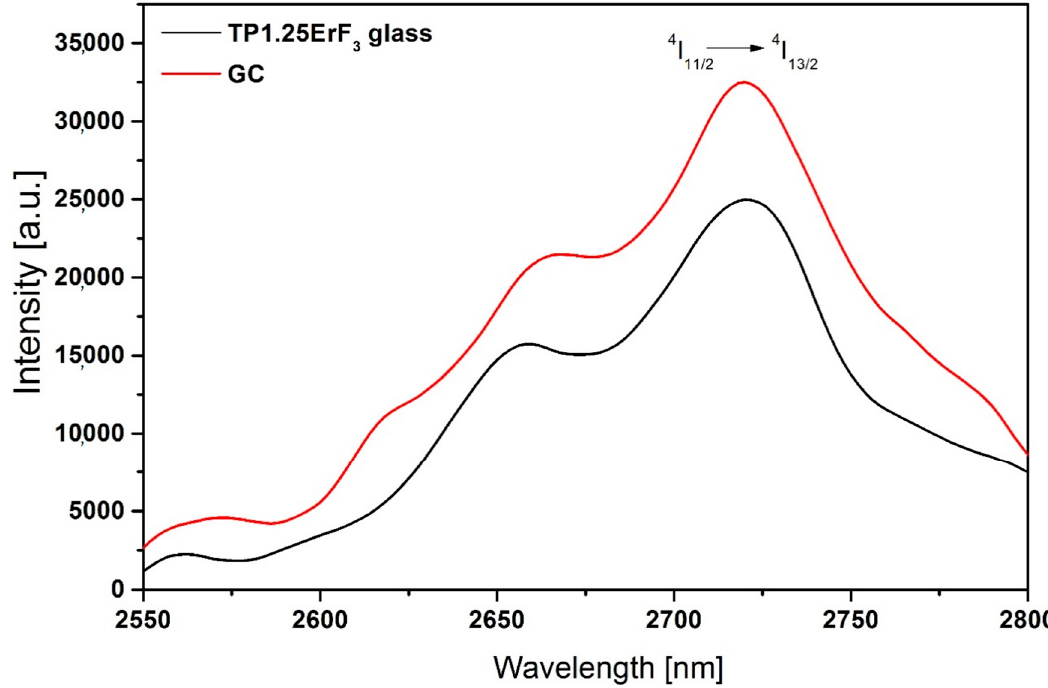
Figure 19. 2725 nm emission spectra of TP1.25ErF 3 glass and glass-ceramic.